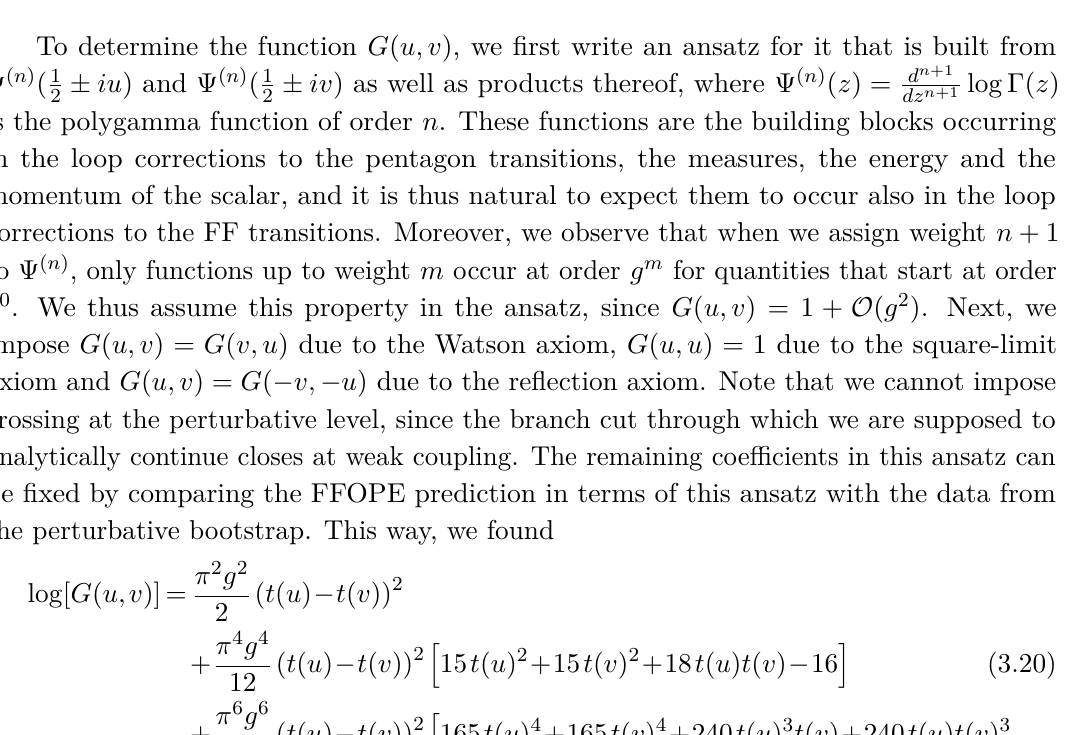
Figure 2 . Interplay between the FF transition bootstrap and the perturbative